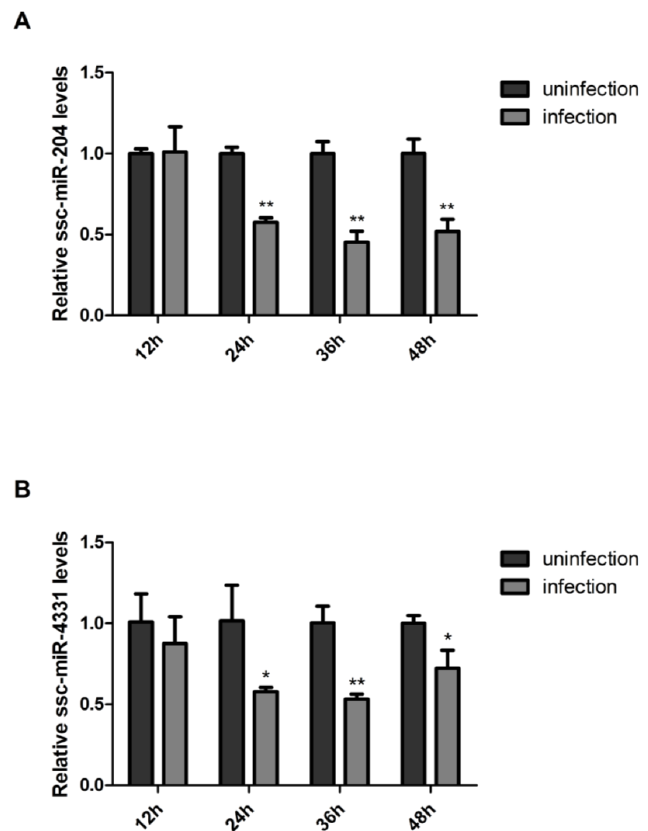
Figure 6. SIV-H1N1/2009 infection downregulated the expression of ssc-miR-204 and ssc-miR-4331. NPTr cells were infected with SIV-H1N1/2009 and harvested at 12, 24, 36 and 48 h post-infection, respectively. Total cellular RNA was extracted and subjected to RT reaction. The expression levels of ssc-miR-204 ( A ) and ssc-miR-204 ( B ) were determined by qRT-PCR methods. All data were standardized to 1 in uninfected cells for each time point. Significant levels were analyzed by Student’s t -test, * p ≤ 0.05, ** p ≤ 0.01.